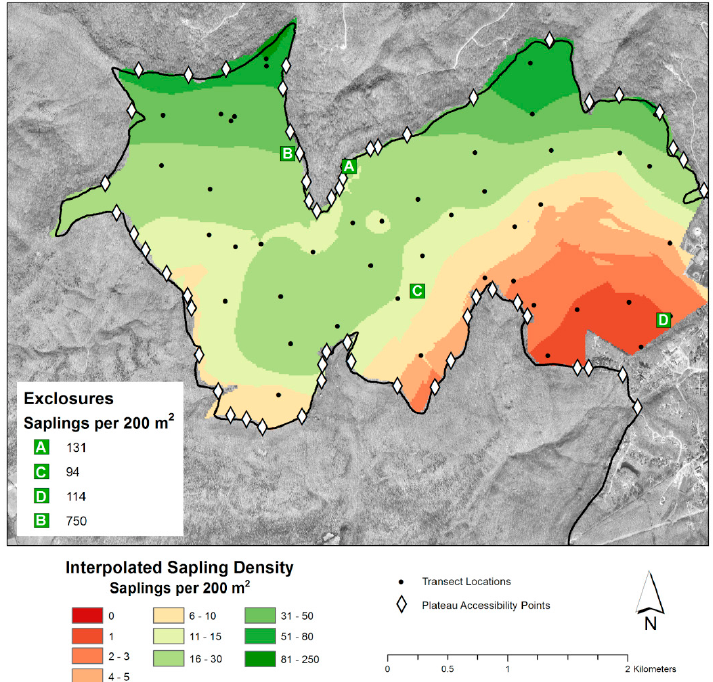
Figure 1. The study site is surrounded by a steep bluff (outlined in black) with various potential access zones (white diamonds). Sapling density was determined in transects (represented by black circles) per 200 m 2 in 2012. Sapling density per 200 m 2 within exclosures is shown. Data were interpolated in ArcMap using kriging to give estimated sapling densities across the landscape. Background imagery from United State Geological Survey National Aerial Photography Program (NAAP).